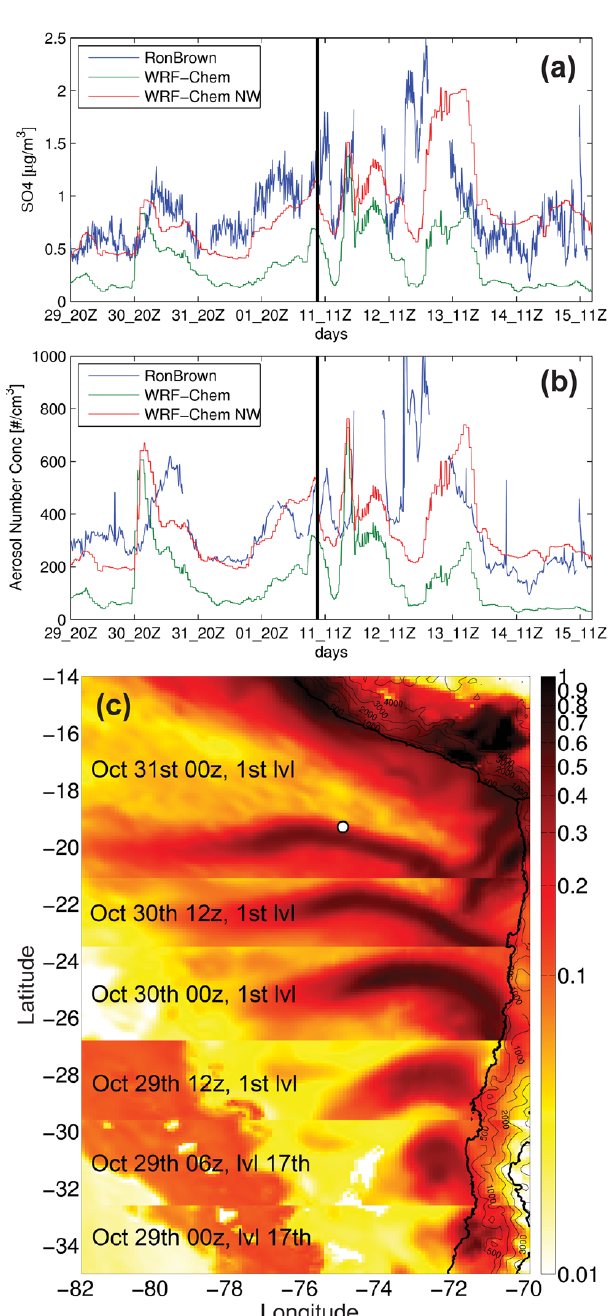
Fig. 8. (a) Time series for observed and modeled SO 4 . (b) Time series for observed and modeled aerosol number concentration for diameters over 13nm and 40nm respectively. Black thick lines in (a) and (b) divides both periods that Ron Brown stayed 4 days on 75 ◦ W: 29 October–1 November and 11–15 November. (c) Com- posite of NW model second bin (78–156nm aerosol diameter) SO 4 concentration in µgm − 3 . Each composite follows the same plume since it is emitted on Central Chile until it reaches Ron Brown (marked by a circle) two days after. The two most southern compos- ites are extracted from level 17 ( ∼ 670m over sea level) while the rest are extracted from the first model level. Scale is